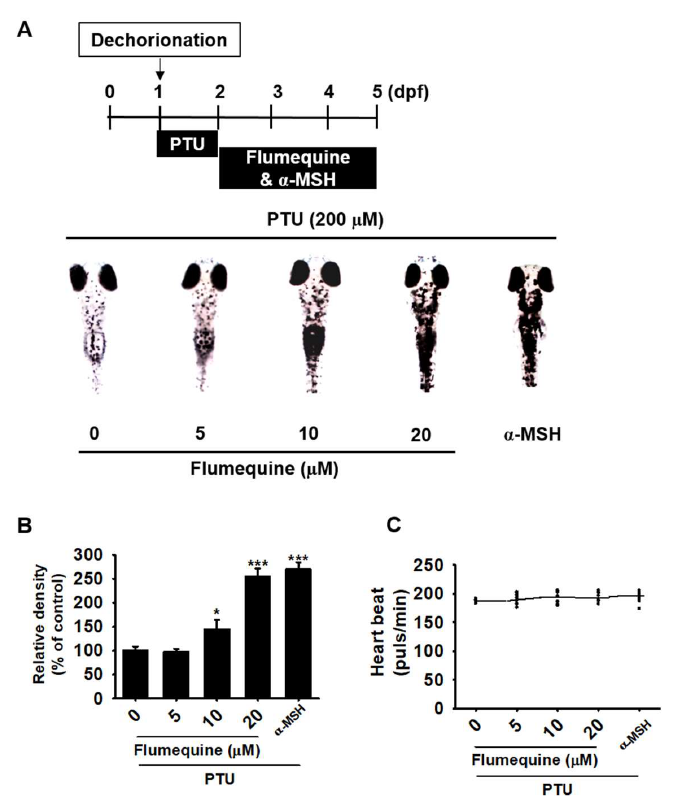
Figure 5. Flumequine upregulates melanin pigmentation in zebrafish larvae. ( A ) The chorion of zebrafish larvae ( n = 20) was removed at 1 dpf and they were treated with PTU (200 µ M) for 24 h (by 2 dpf). Then, flumequine (0–20 µ M) was added to 2 dpf zebrafish larvae for 72 h (by 5 dpf), and images were captured at 5 dpf under an Olympus microscope (40 × ). ( B ) Relative density was calculated using Image J software. ( C ) Average heart beat of zebrafish larvae ( n = 20) was measured to assess the toxicity of flumequine. The results are the average of three independent experiments and are represented as the mean ± SEM. *** , p < 0.001 and *, p < 0.05 vs. untreated control.